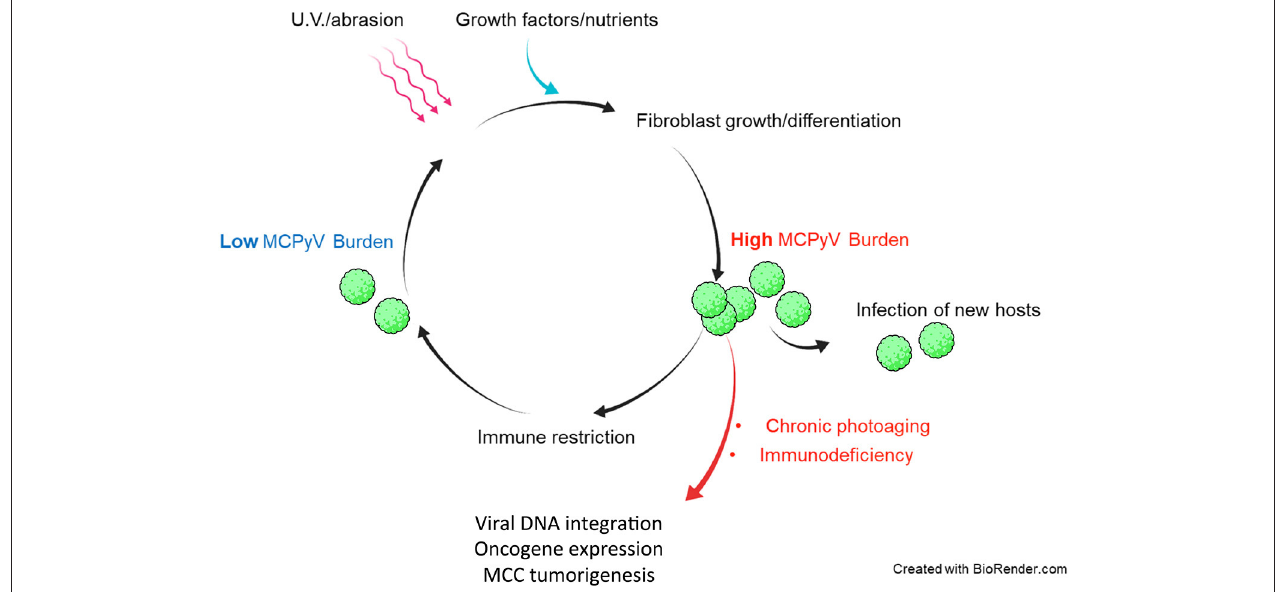
FIGURE 2 | Hypothetical model of in vivo MCPyV persistence and dysbiosis leading to MCPyV-positive MCC. Healthy individuals support both low and high MCPyV loads, depending on external factors. U.V. irradiation or abrasion of the skin could cause infected dermal fibroblasts to upregulate MCPyV gene expression and replication. Damaged and repairing skin could be a path by which MCPyV escapes the dermis to infect new hosts. Healthy immune responses may reduce the MCPyV burden asymptomatically. In immunocompromised patients and those with years of chronic U.V. damage, the microenvironment of the skin may be altered in a way that induces MCPyV entry into the original cell of MCC and integration into the host chromatin to drive MCC